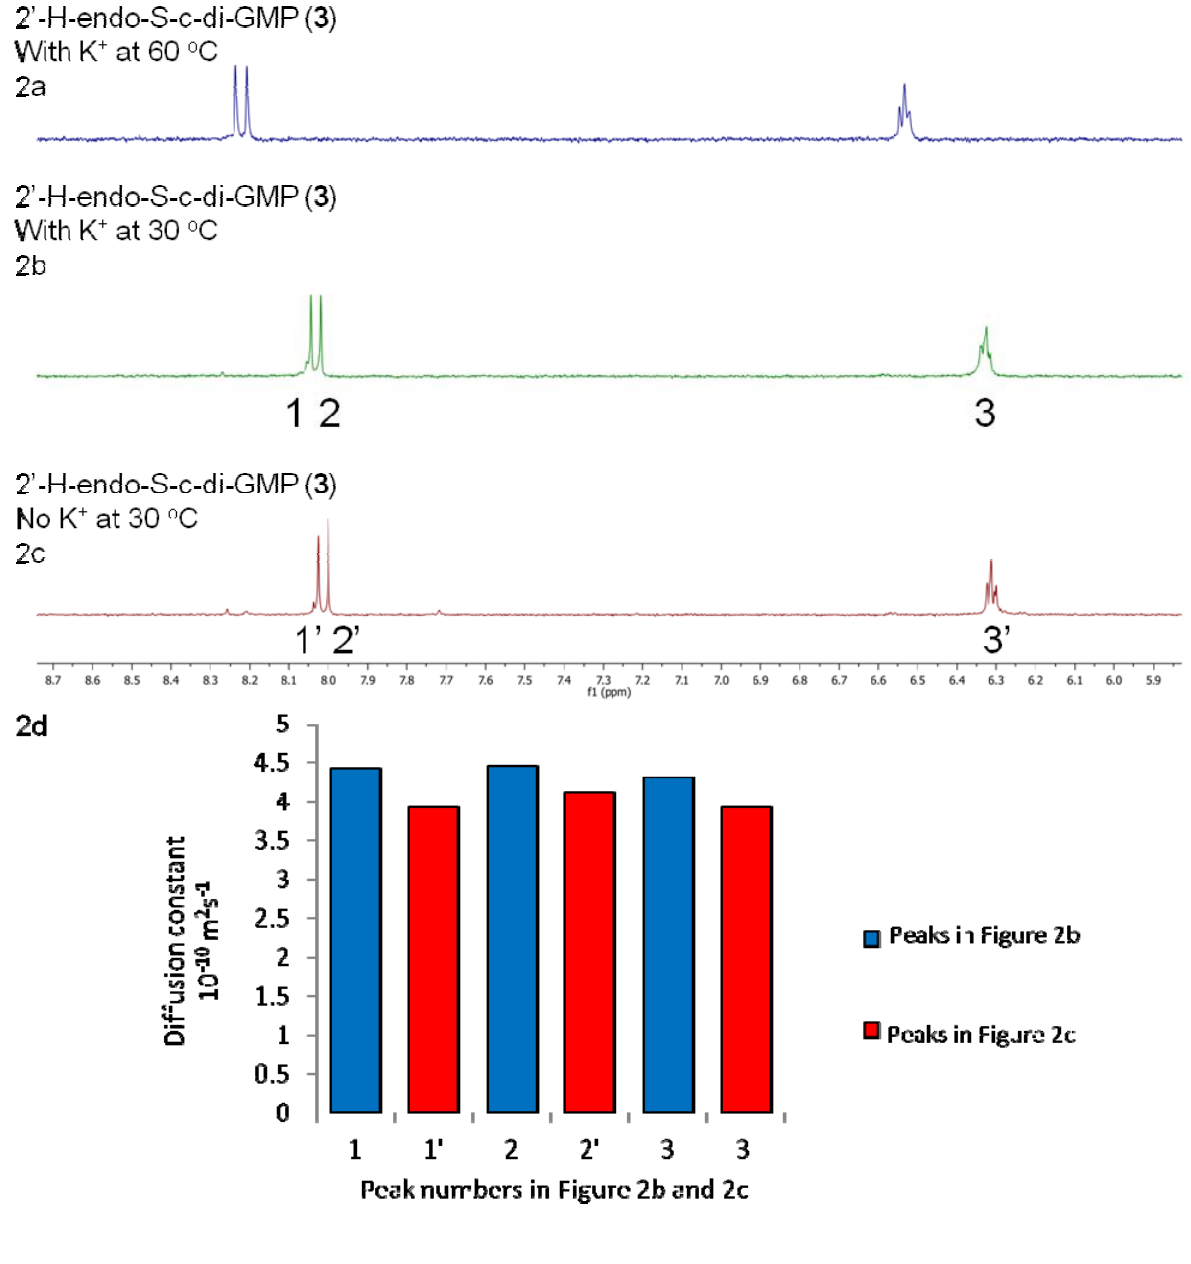
Figure 2. 1 H-NMR stacked spectra of 3.0 mM analogue 3 in D S-c-di-GMP, 100 mM KCl, 60 °C. ( b ) 3.0 mM 2'-H-endo-S-c-di-GMP, 100 mM KCl, 30 °C. ( c ) 3.0 mM 2'-H-endo-S-c-di-GMP, no metal cation, 30 °C. ( d ) 3.0 mM 2'-H-endo-S-c-di- GMP, T /T relaxation analysis (from DOSY 1 2